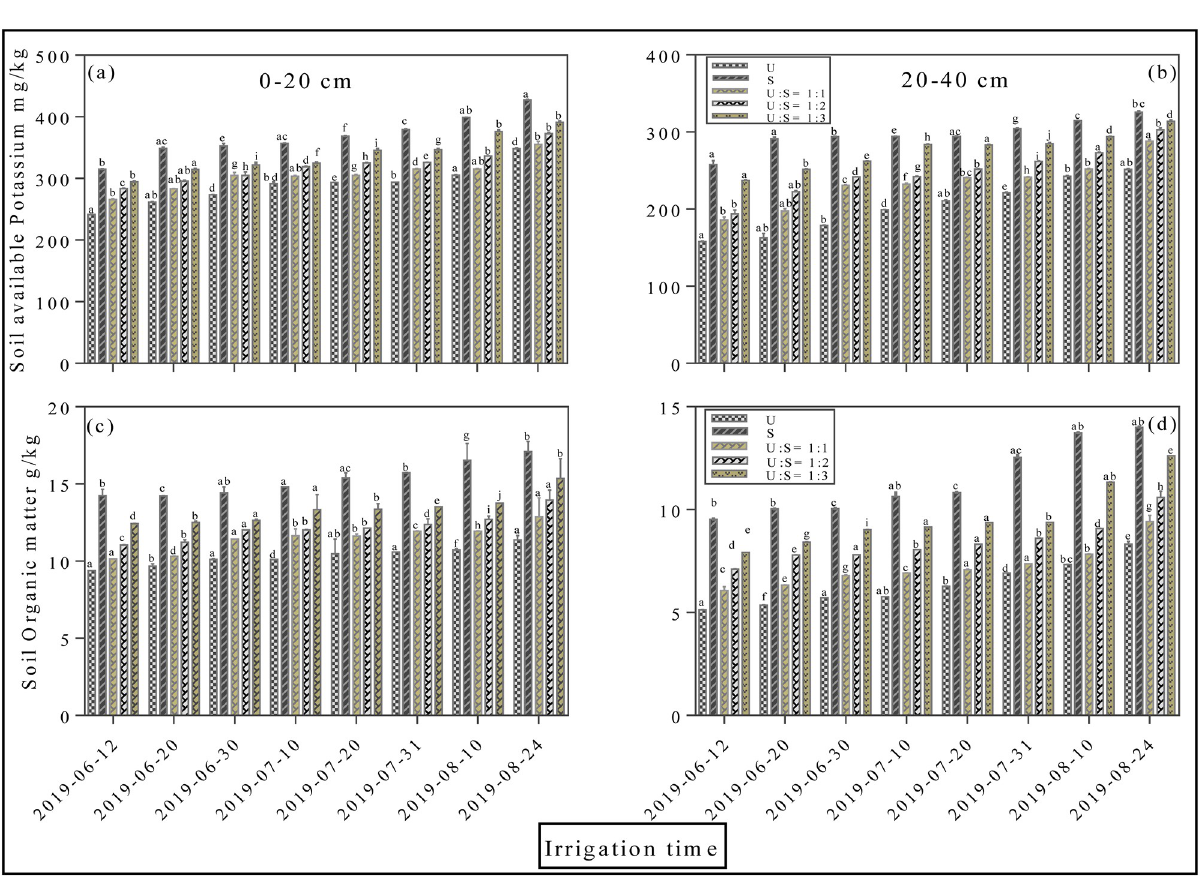
Fig 7. Effects of different mixing ratio irrigation on soil available potassium (mg/kg) and soil organic matter (g/kg): Fig (5a) and (5b) represents soil available potassium at depth of 0–20 cm and 20–40 cm; Fig (5c) and (5d) represents soil organic matter at depth 0–20 cm and 20–40 cm. Data were presented as the mean ± standard error (SE) of three replicates at a significance level of p < 0.05 (based on ANOVA).